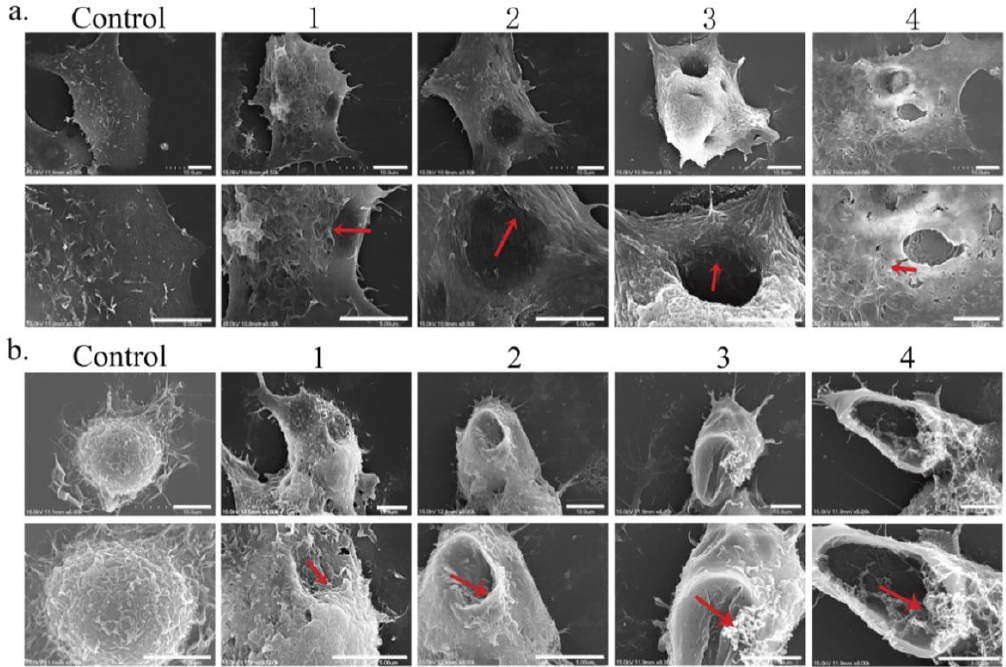
Figure 3. SEM images of A549 ( a ) and Raw264.7 ( b ) cells undergoing cell membrane degradation as a result of GO exposure (in its ultimate stage, >24 h). ( b ) Images 1, 2, 3, and 4 reflect different degrees of membrane stress detected during different incubation stages [48].